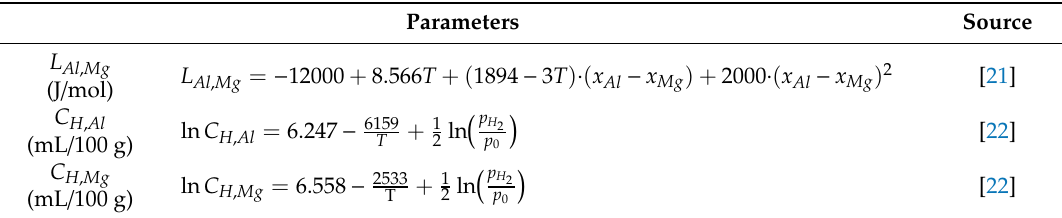
Table 2. Interaction parameter L Al , Mg of molten Al-Mg alloys and hydrogen solubilities C H , Al in liquid pure Al and C H , Mg in liquid pure Mg.